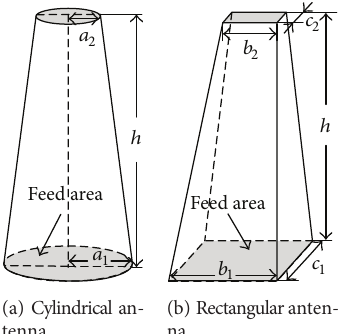
Figure 1: Structures of dielectric rod antennas.